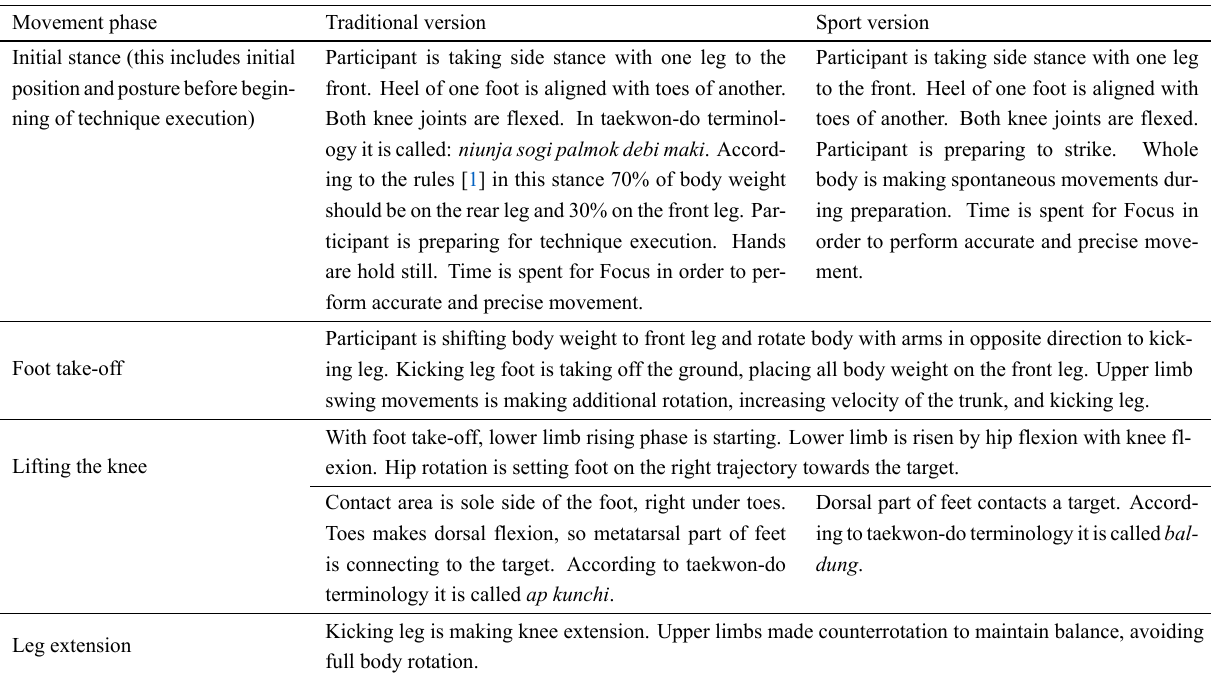
Table 1. Descriptive comparison of movement phases of roundhouse kicks in traditional and sport version.